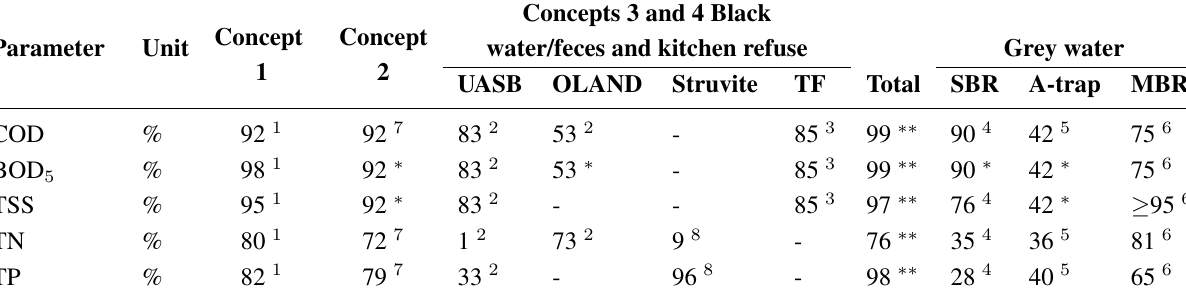
Table 3. Pollutant removal efficiencies of biological reactors in Concept 1 and 2, and of up-flow anaerobic sludge blanket reactor (UASB), oxygen limited anaerobic nitrification denitrification (OLAND), struvite precipitator, trickling filter (TF), sequencing batch reactor (SBR), A-stage of AB-process (A-trap) and membrane bioreactor (MBR) in Concepts 3 and